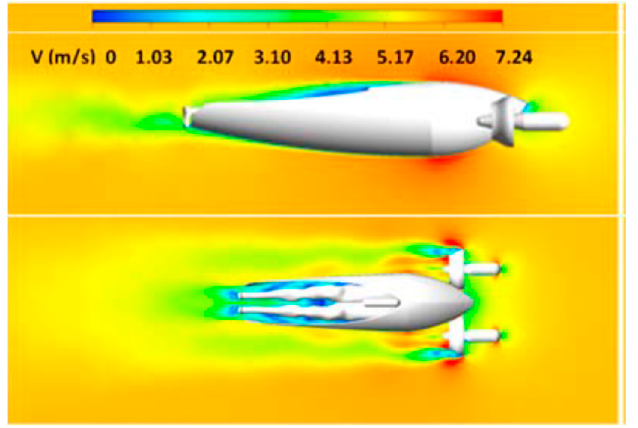
Figure 1. CFD velocity cloud of DPV–diver coupled model in M.R.Dadeghizadeh’s research